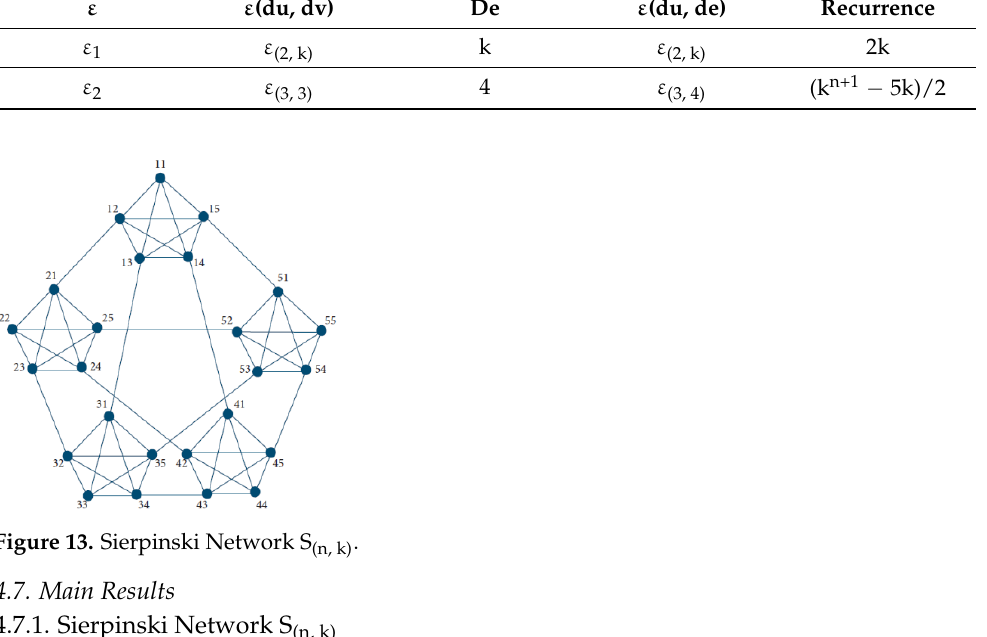
Table 8. Edge partition of Sierpinski Network S (n, k).